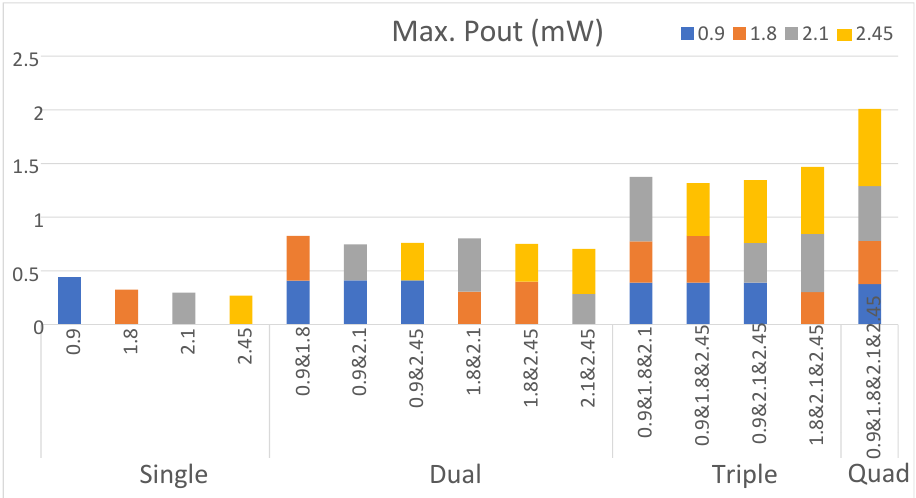
Figure 21. A chart for the output voltage, output power, and conversion efficiency.